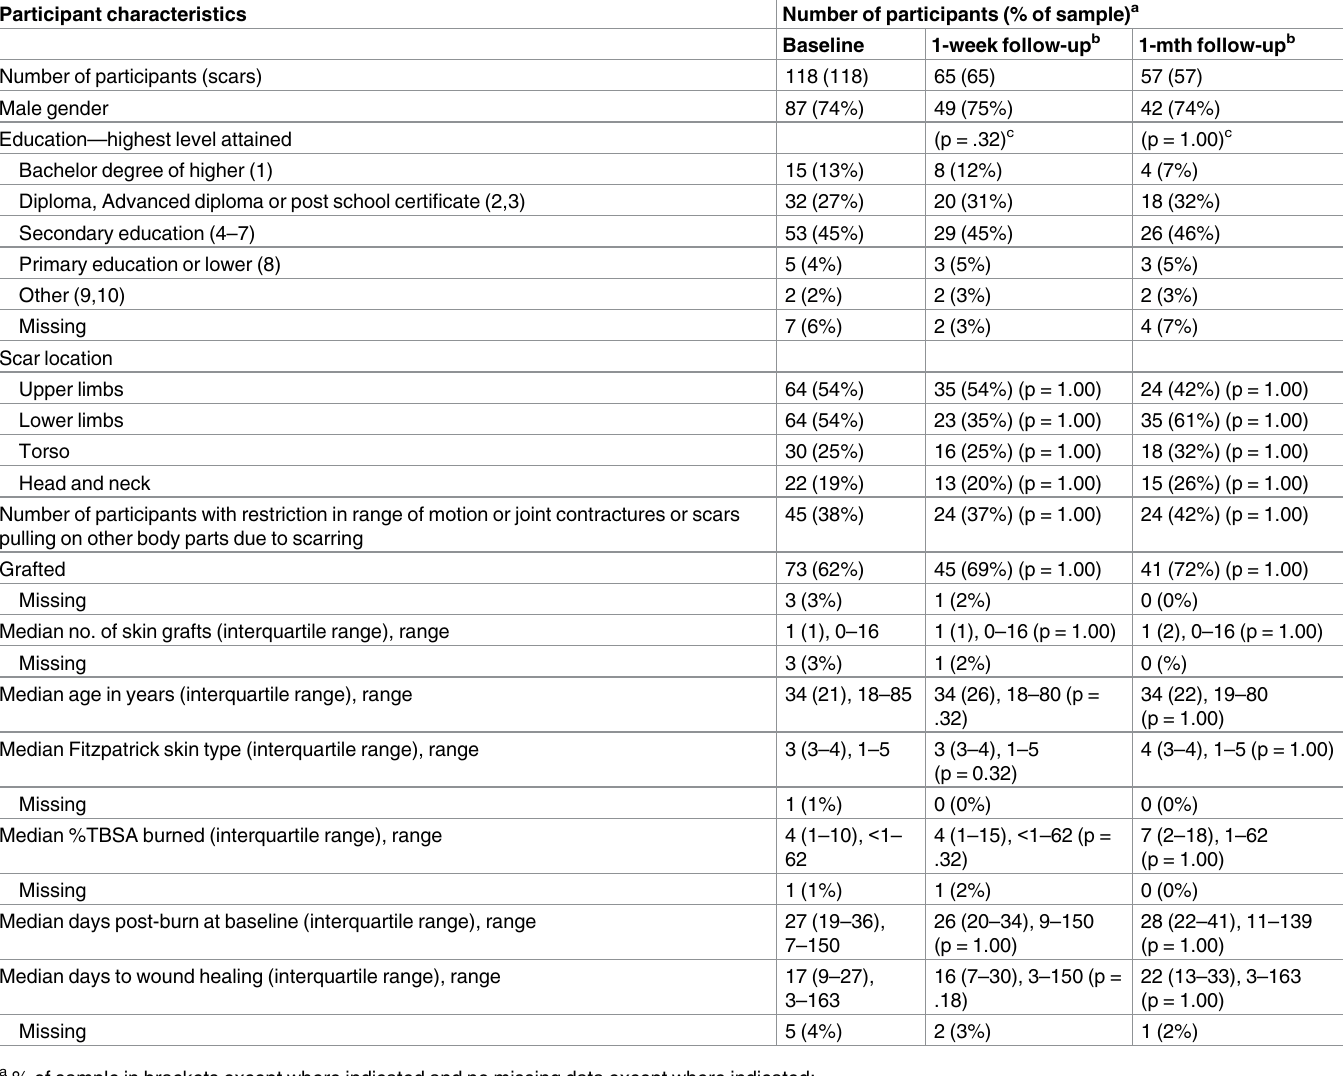
Table 1. Participant sociodemographic, injury, scar and skin type characteristics at each testing